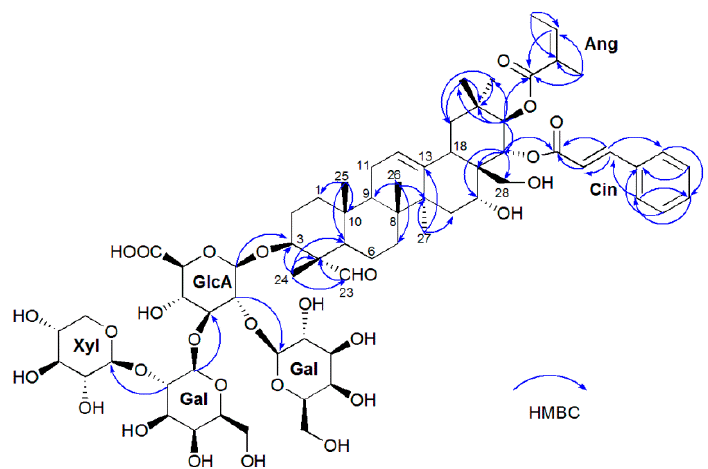
Figure 1. Structure of compounds.